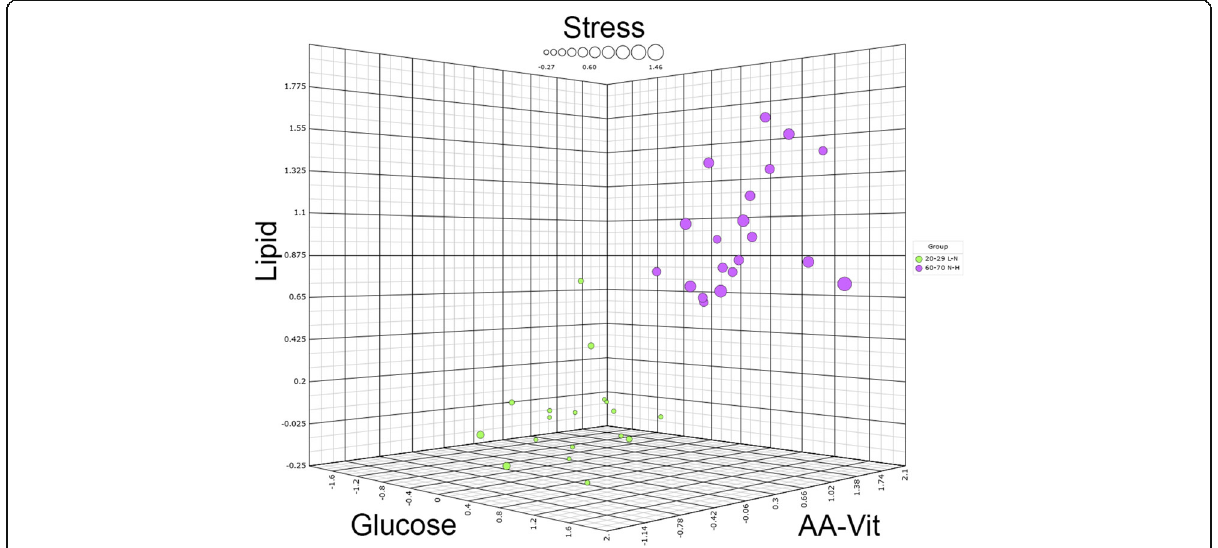
Fig. 1 Overview of the reference groups in the main health space, with both sexes included. Three spatial axes are labeled for the domain they represent. “ AA-Vit ” stands for amino acids and vitamins. Groups labeled using their respective age intervals as well as their body fat percentage intervals, L for low, N for normal, and H for high. The dot size represents the “ metabolic stress ” axis of the health space